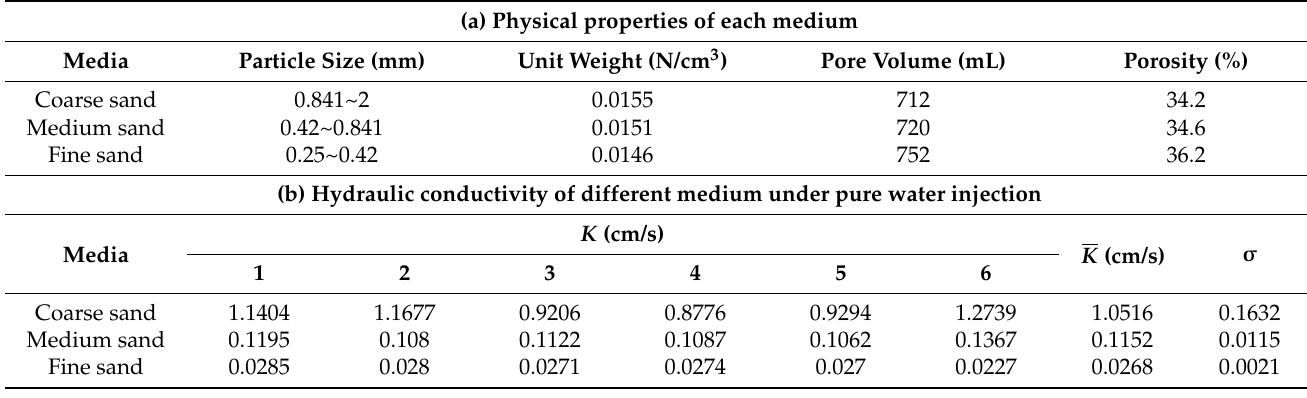
Table 3. Physical properties and Hydraulic conductivity of each